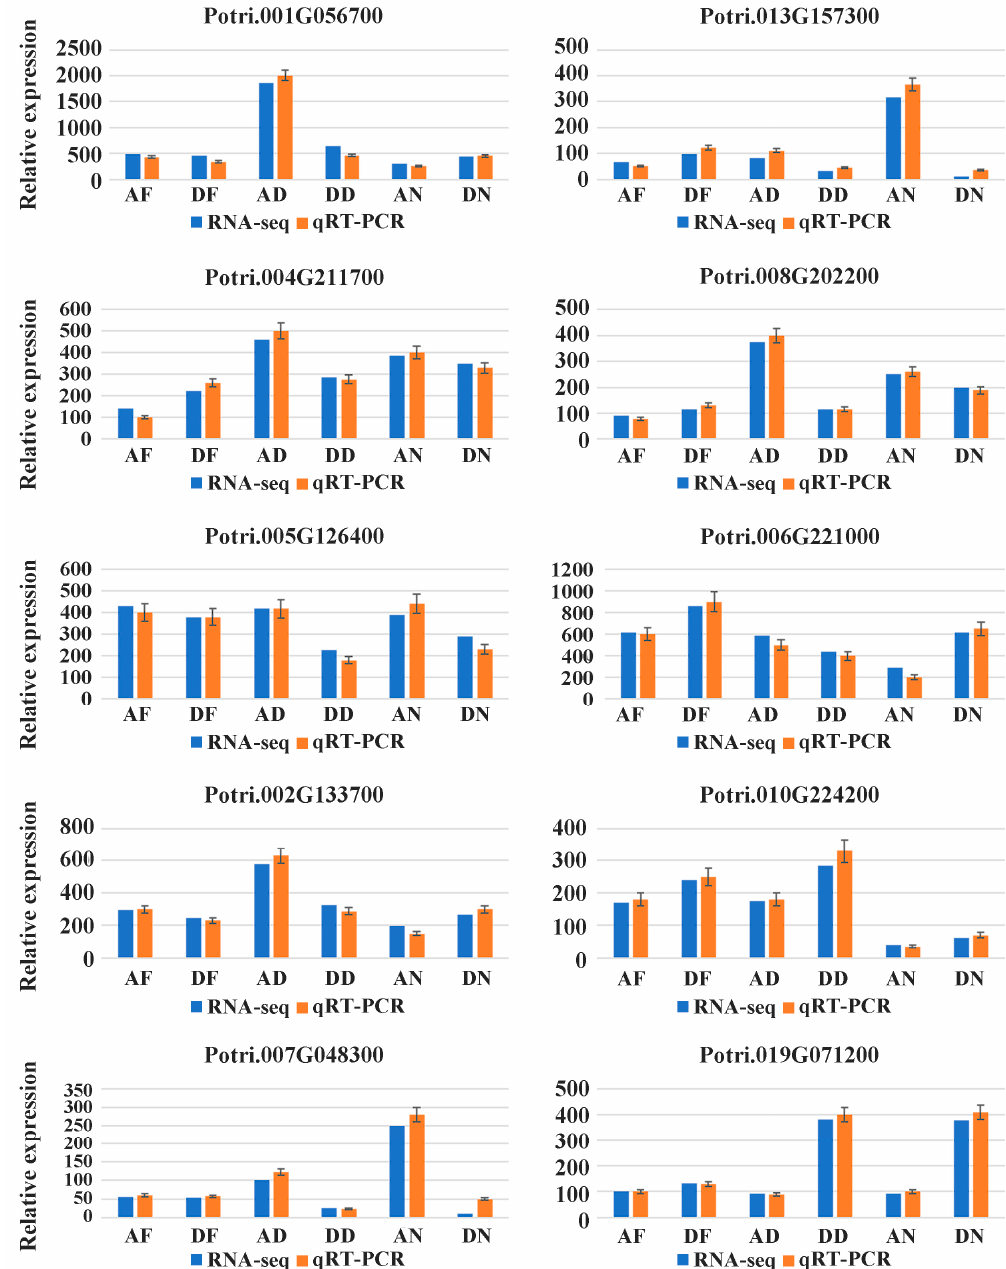
Figure 2. Analysis of differential expression genes by qPCR and RNA-seq. These 10 genes were randomly selected from the data.